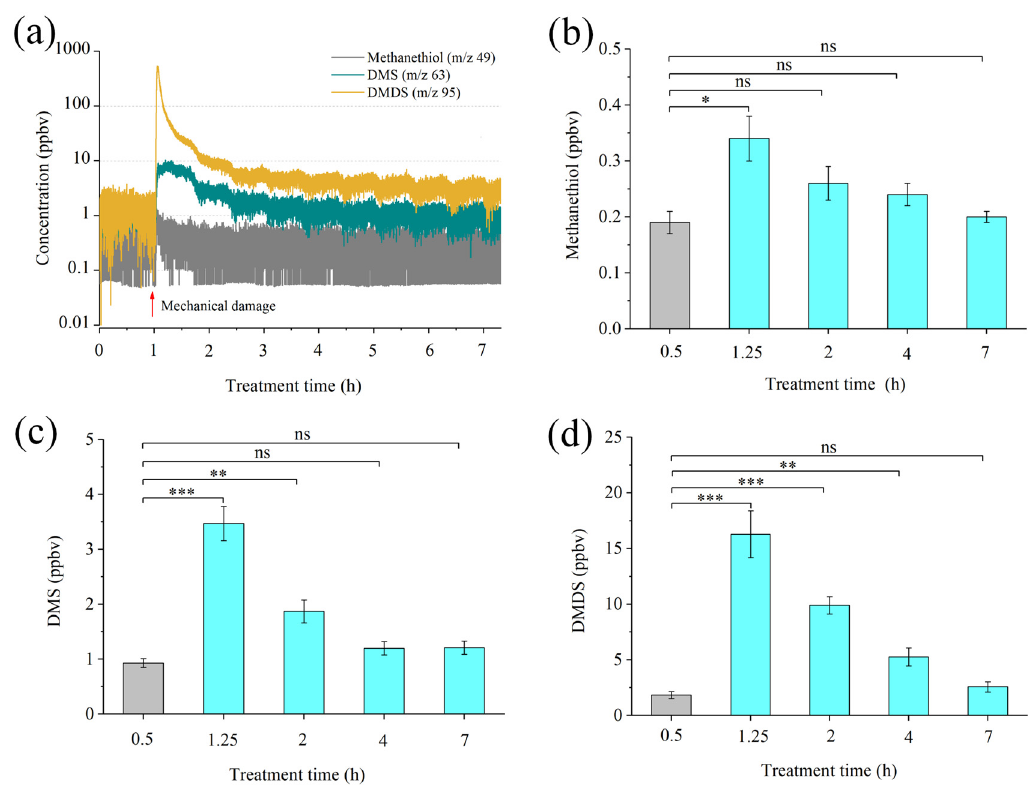
Figure 1. Determination of sulfur volatiles from guava plants with or without mechanical damage with a proton-transfer-reaction mass spectrometer (PTR-MS). ( a ) Real-time determination of sulfur volatiles from guava plants. ( b – d ) The concentration of methanethiol, dimethyl sulfide (DMS), and dimethyl disulfide (DMDS) at each time point. Data are shown as means ± SE ( n = 6). Asterisks indicate significant differences between mechanical damaged and control (undamaged) plants based on Student’s t -test (* p < 0.05, ** p < 0.01, and *** p < 0.001); ns, no significant